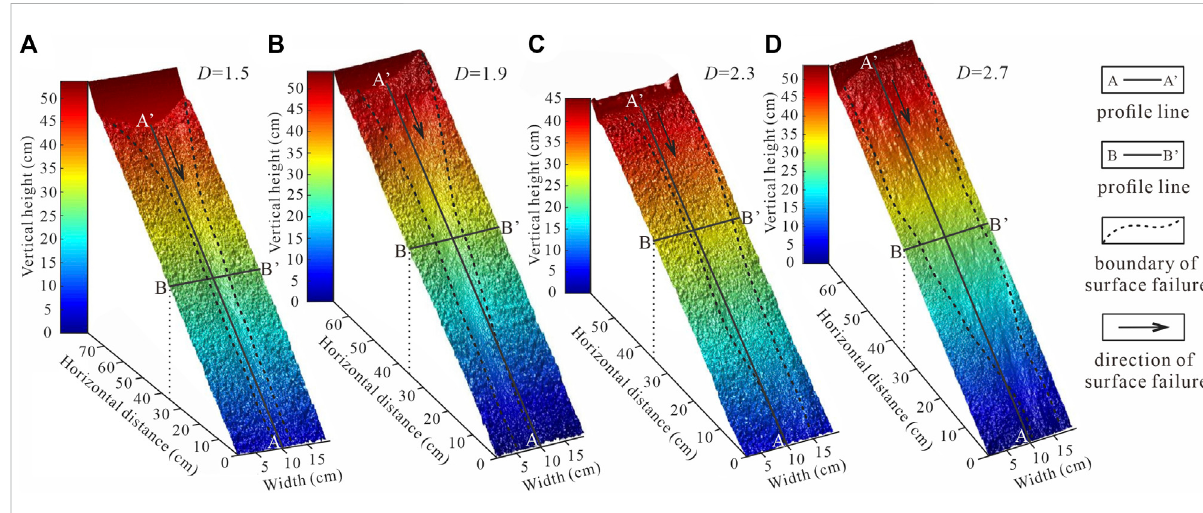
FIGURE 6 Sur fi cial failure of granular slopes with different fractal dimensions (A) D = 1.5; (B) D = 1.9; (C) D =2.3; (D) D =